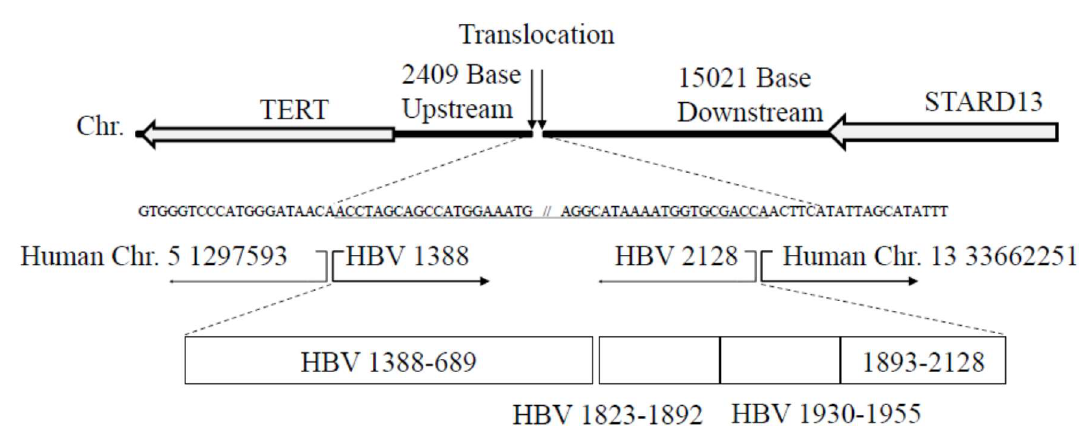
Figure 3. Translocation of chromosomes (5; 13) with hepatitis B virus (HBV) integrants. The results were confirmed by Sanger sequencing methods. Chr, chromosome (Hg19); TERT, telomerase reverse transcriptase; STARD13, StAR-related lipid transfer domain containing 13 genes.